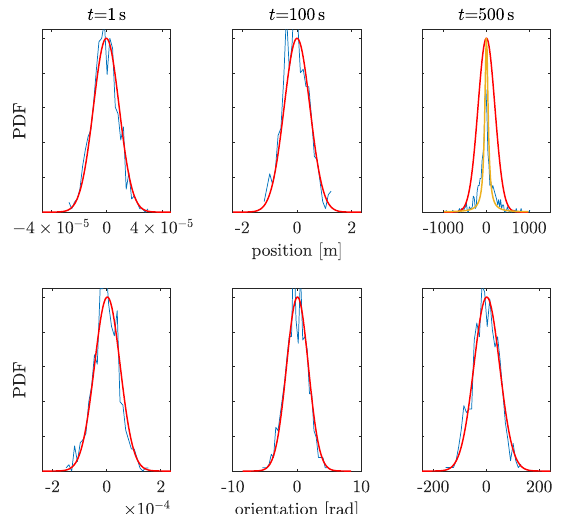
Figure 7. High − frequency accelerometer position ( top ) and orientation ( bottom ) uncertainties for different times. Results are shown as probability density functions (PDF) calculated from 1000 sim- ulations. Blue: simulation results. Red: Gaussian distribution fit. Ocher: Cauchy distribution fit.